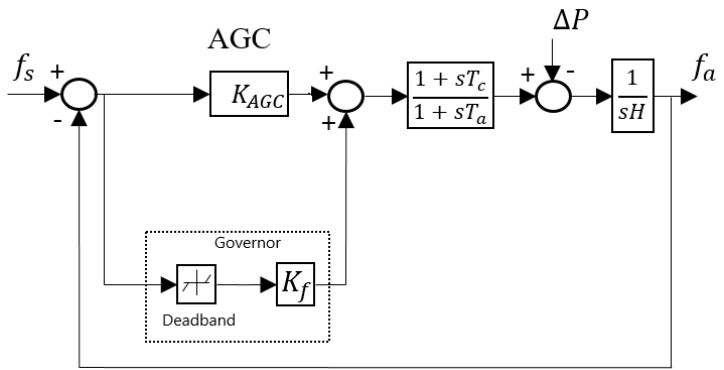
Figure 1. Frequency dynamics